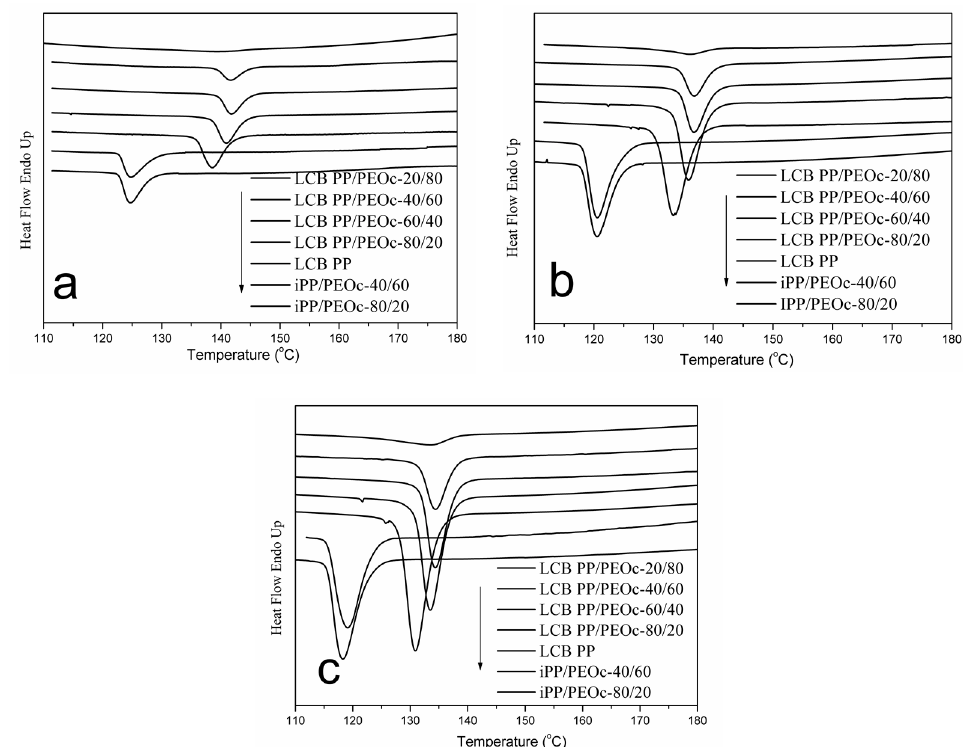
Figure 7. DSC curves for LCB PP/PEOc and iPP/PEOc blends at a cooling rate of ( a ) 1 °C min − 1 ; ( b ) 3 °C min − 1 ; and ( c ) 5 °C min − 1 .